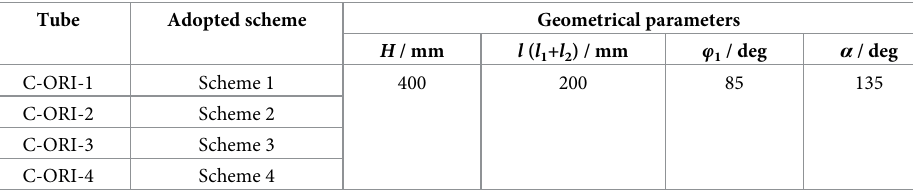
column joint in building structures, pin ends are used for the tubes. In order to simulate the pin ends, MASS21 element is placed at both ends, connecting nodes of the end plates by MPC184 Rigid Beam elements. In such way, with the constraints at MASS21 elements, rota- tions about the ends as a whole are allowed. The external load and the reaction force is applied at MASS21 elements. The loading end (the upper end) is allowed to translate in z direction and rotate about x and y directions (UX = UY = ROTZ = 0). The support (the lower end) is allowed to rotate about x and y directions (UX = UY = UZ = ROTZ = 0). For HL lines in the schemes, node coupling of the translational degrees of freedom along the lines are used. Thus, the lines are able to rotate without resistance. The material of the model is hot rolled steel with a 4-segment piecewise linear constitutive relationship [31], which is shown in Fig 8. The mate- rial parameters are listed in Table 2, where f is the yield stress, f is the ultimate stress, E is the y u elastic modulus, E is the slope of strengthening, ε is the yield strain, ε is the strain at the st y st onset of stress strengthening, ε is the strain at the ultimate stress and ε is the ultimate strain. u el Displacement-controlled loading is applied in the simulation. In order to ensure the reach of a